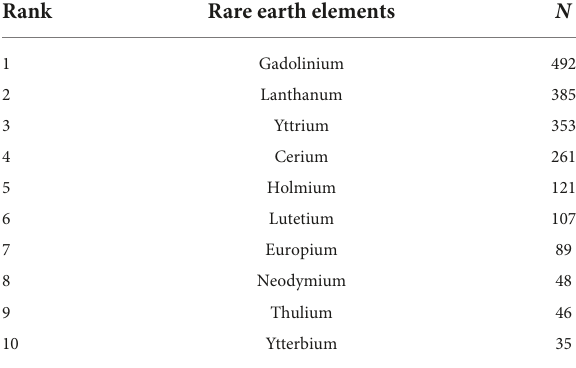
TABLE 4 The top 10 rare earth elements in the research on the association of rare earth elements with cancer. Rank Rare earth elements